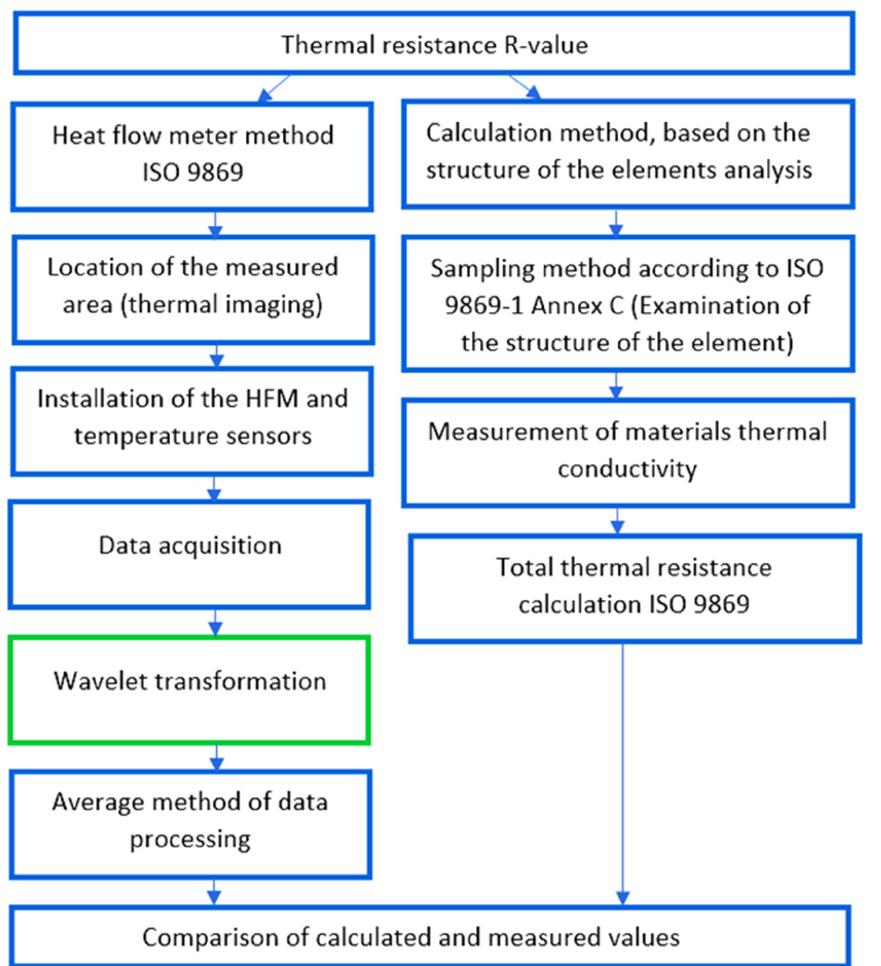
Figure 1. Methodology for evaluating the thermal resistance.